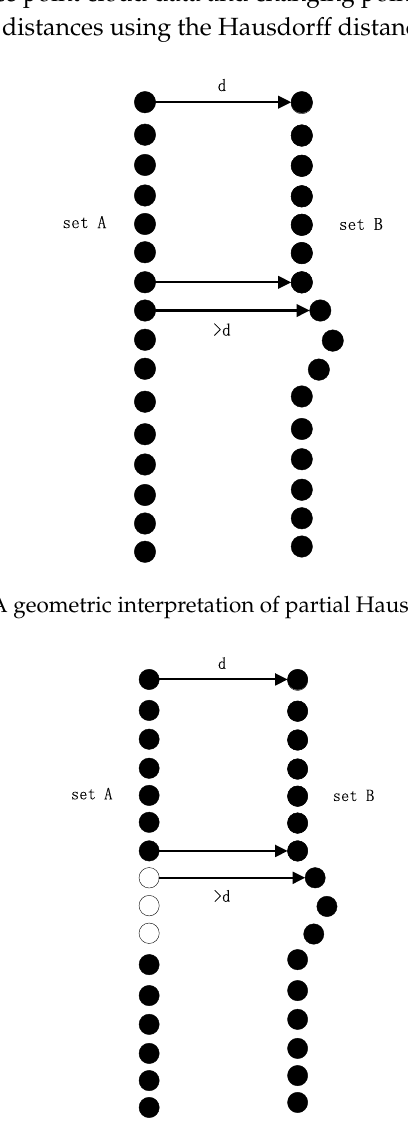
Figure 4. Variational point cloud identification based on partial Hausdorff distance.